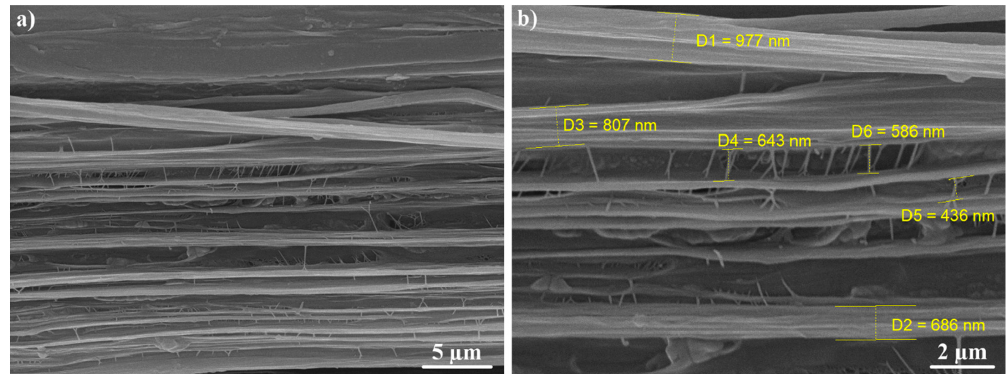
Figure 8. SEM images of fibrillar structure with different magnifications for virgin UHMWPE films. Tensile direction is horizontal.